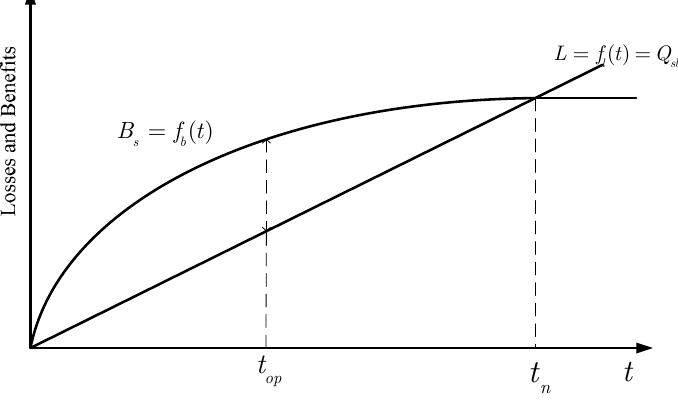
Figure 6. Schematic diagram of soot ‐ blowing optimization.